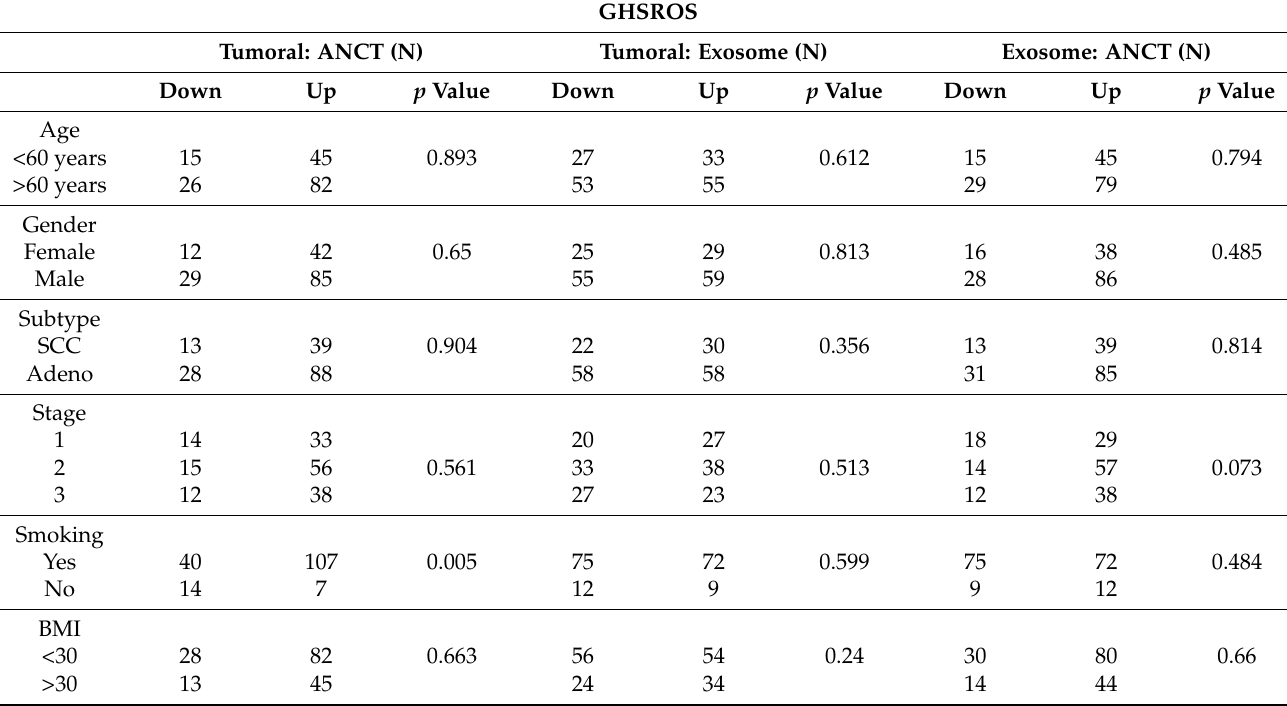
Table 6. The relationship between 5 lncRNAs and clinicopathological